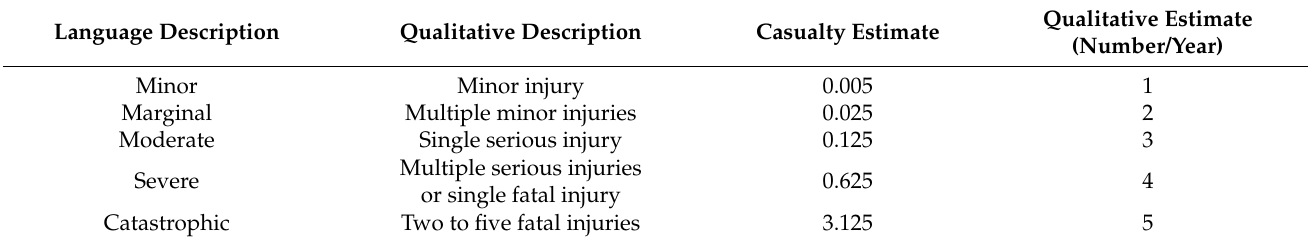
Table 4. Severity level of safety behavior risk of the transportation system.